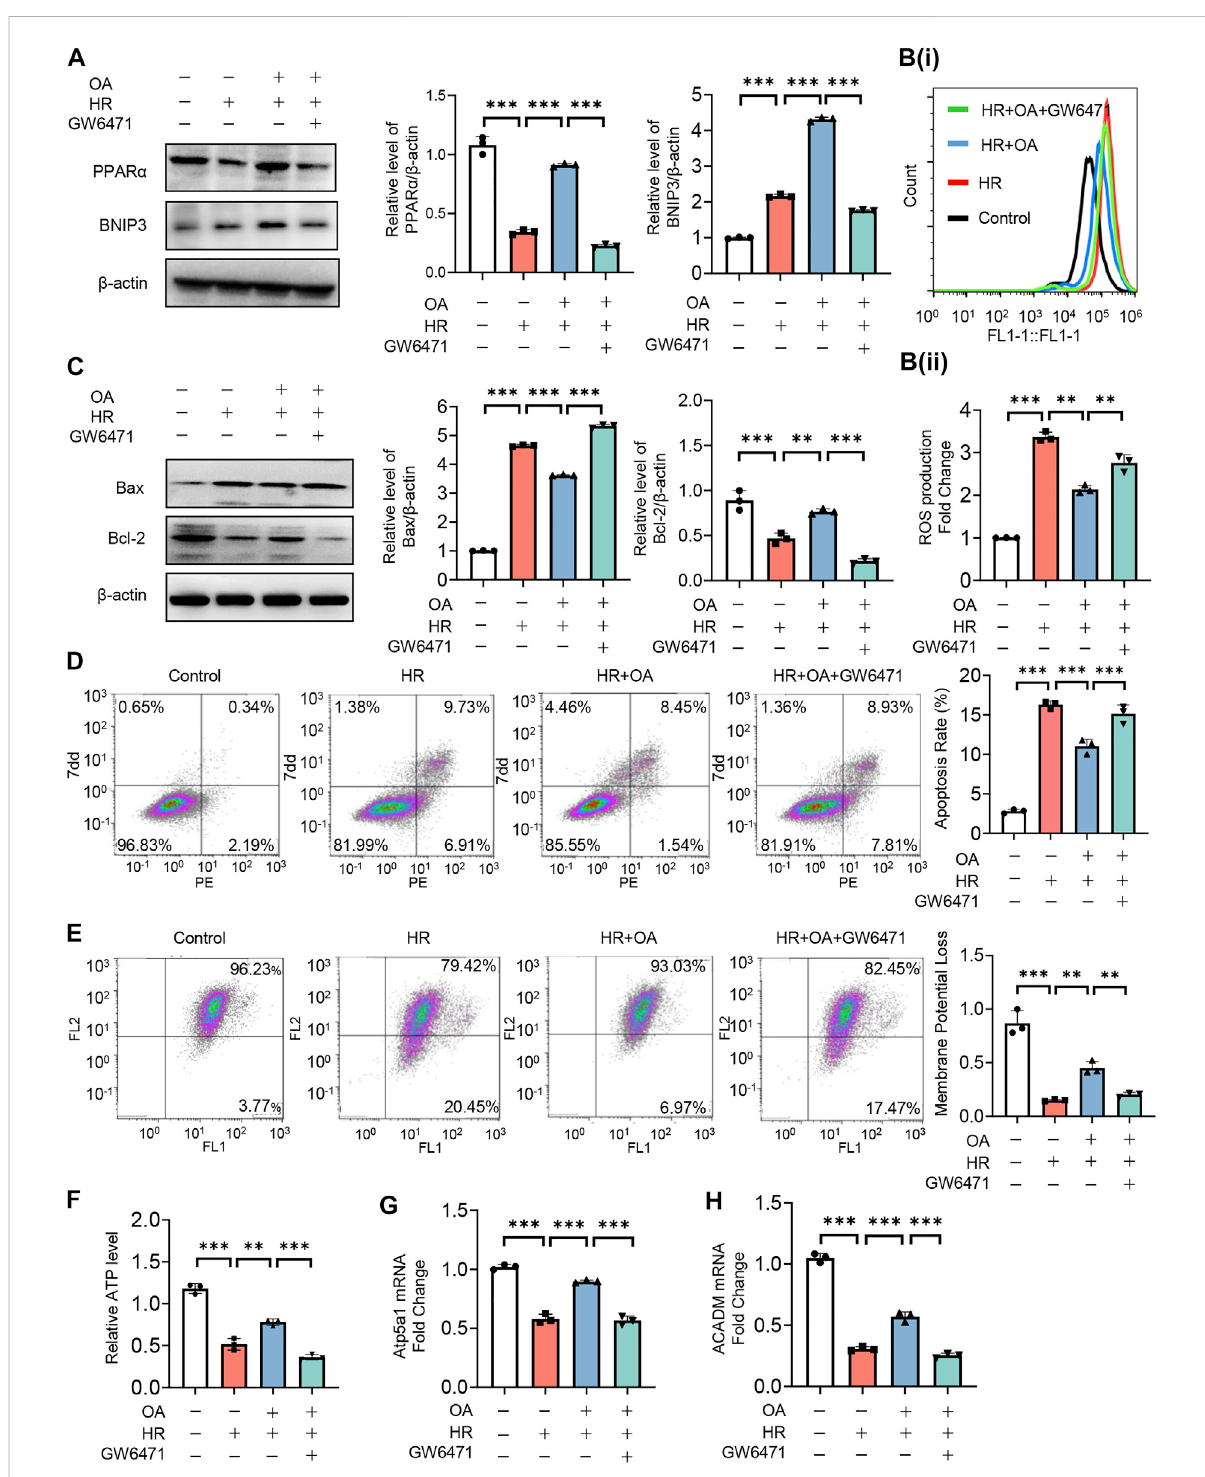
FIGURE 6 OAalleviatesmitochondrialhomeostasisimbalancebyenhancingPPAR α -BNIP3signaling pathway. (A – H) HK-2 cellsweretreatedwithOAand control or GW6471 (PPAR α antagonist) under normal or HR injury conditions, and then the levels of PPAR α and BNIP3 expressions (A) , ROS (B) , apoptosis (C , D) , mitochondrialmembrane potential (E) , ATP (F) , OXPHO-related (G) and FAO-related gene expressions (H) were determined ( n = 3). Data are expressed as means ± SEM. pp P < 0.01, ppp P <